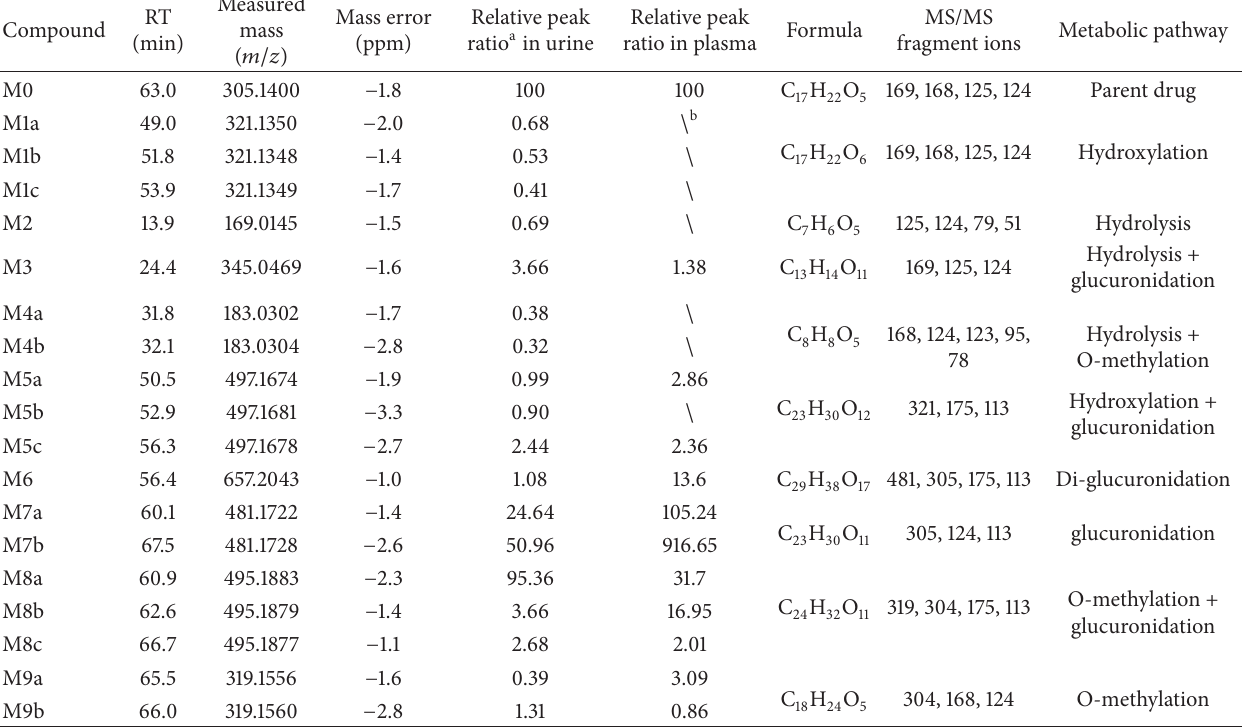
Table 1: Retention time (RT), measured mass, calculated formula by elemental compositions, the mass error between the calculated and measured values, MS/MS fragment ions, and metabolic pathway as well as relative peak ratio for each metabolite of BG in rat plasma and urine after oral